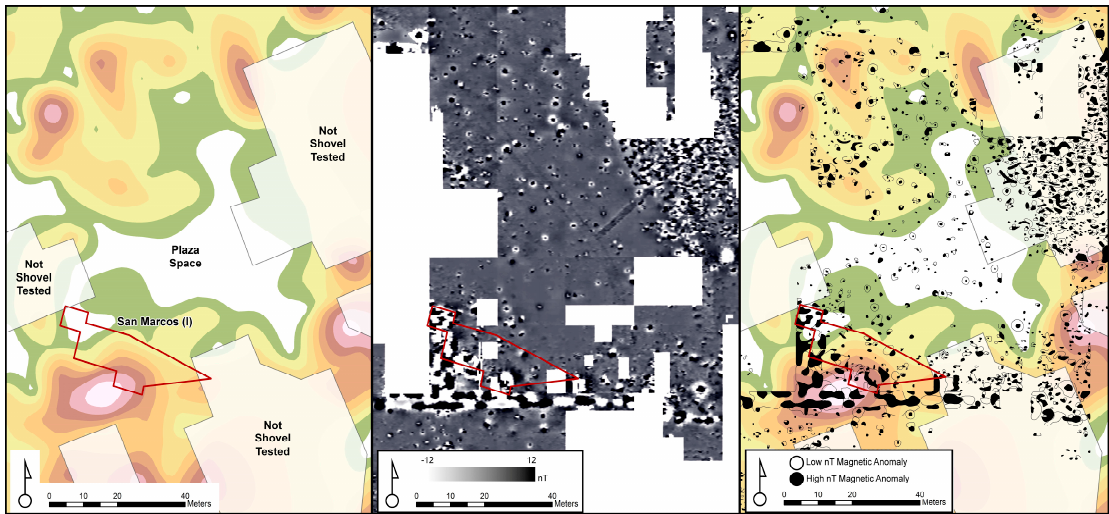
Figure 10. The distribution of all Spanish period artifacts recorded through a shovel test survey. Areas whited-out were not shovel tested. Contour spacing is 1 m. Contours are based on the LiDAR dataset and use the NAD 1983 and NAV 1988 horizontal and vertical datum, respectively.